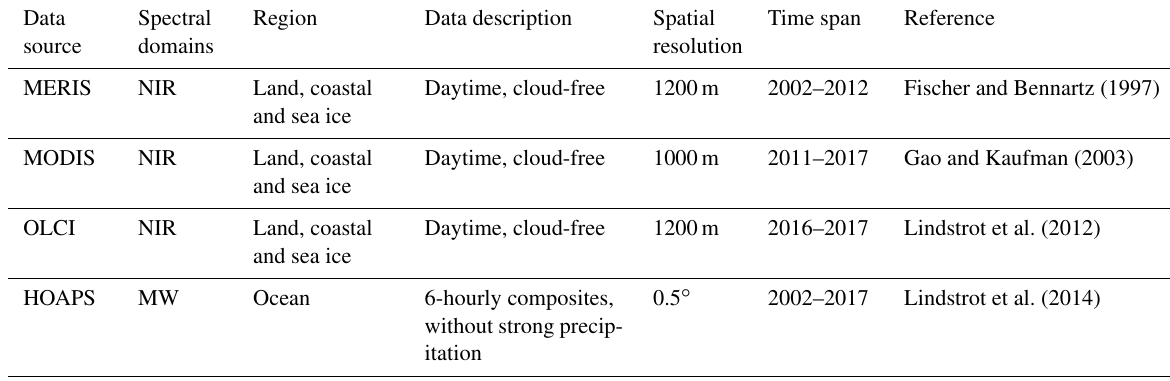
Table 1. Summary of the characteristics of CCI water vapour data TCWV-COMBI.